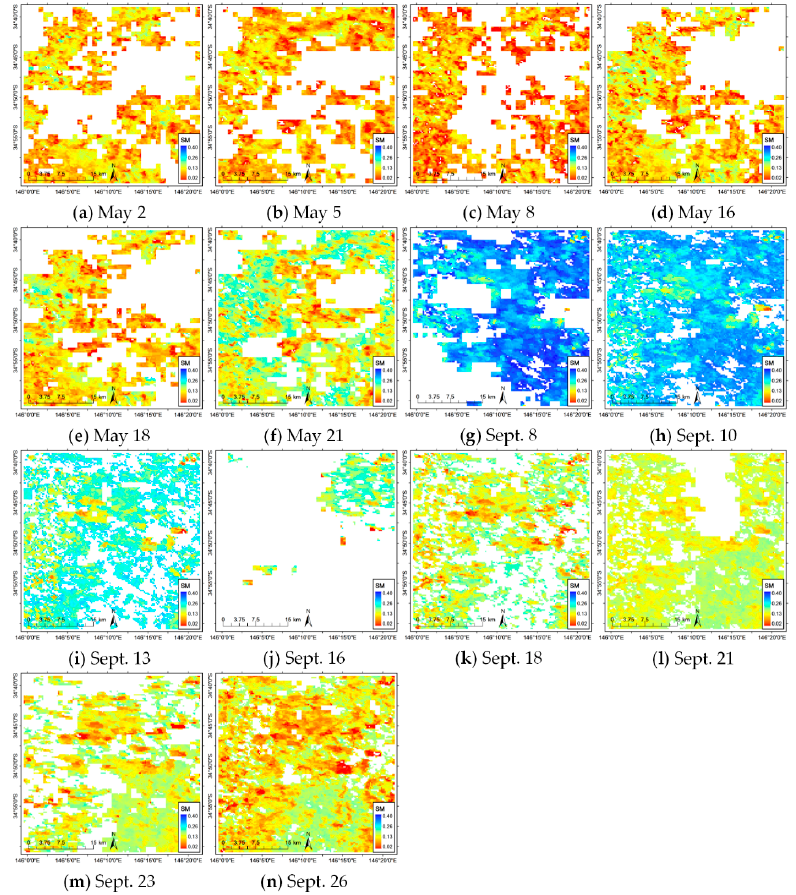
Figure 5. ( a – n )Disaggregated soil moisture at 250 m resolution. Missing pixels were set to white due to the fully cloud-covered